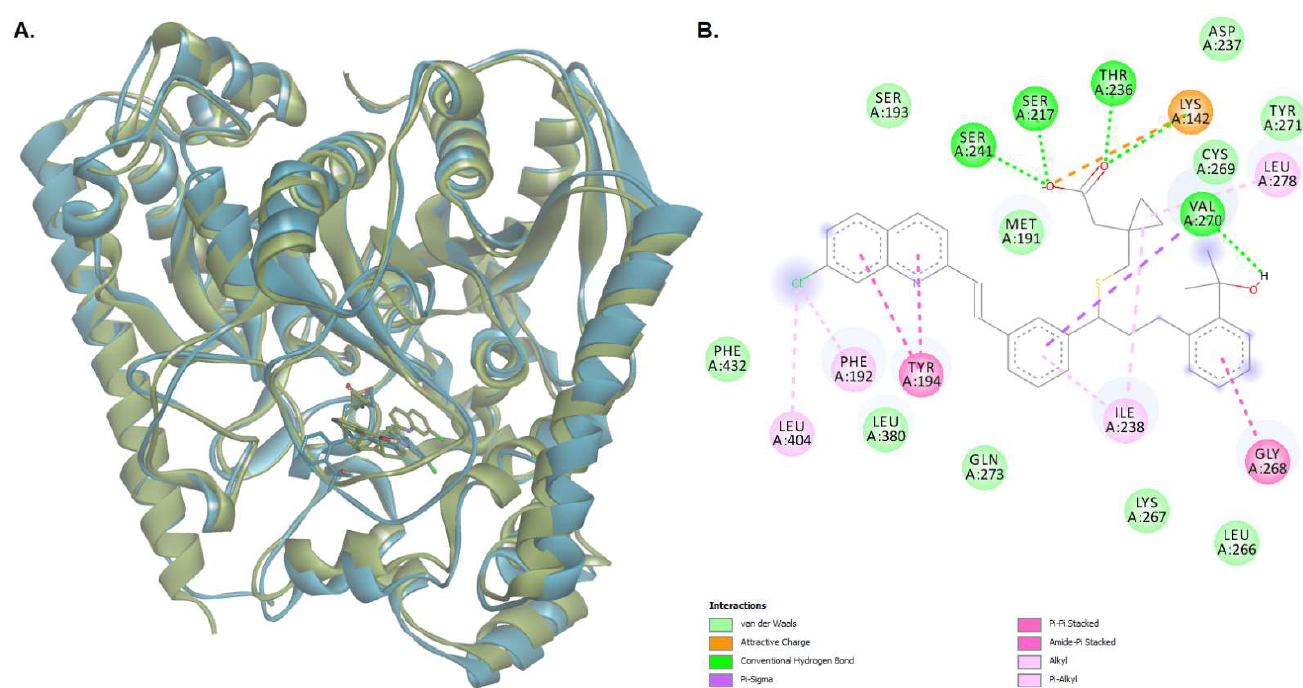
Figure 11. ( A ) The superposition of the protein-ligand complex at the end of the MD simulation over the initial structure (light green—initial conformation; light blue—final conformation); ( B ) 2D diagram of protein-ligand interactions between FAAH and montelukast after the 125 ns MD simulation.